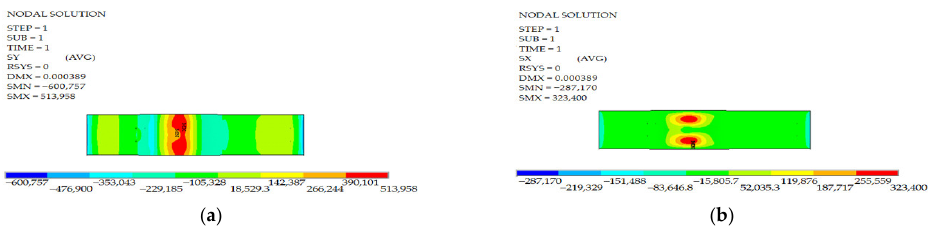
Figure 20. Stress distribution diagram of the base plate under 15 million applications of fatigue load (working condition 2). ( a ) Longitudinal stress of base plate; ( b ) lateral stress of base plate. Table 5. Maximum stress of the base under working condition 2. 1 Time of Fatigue Load